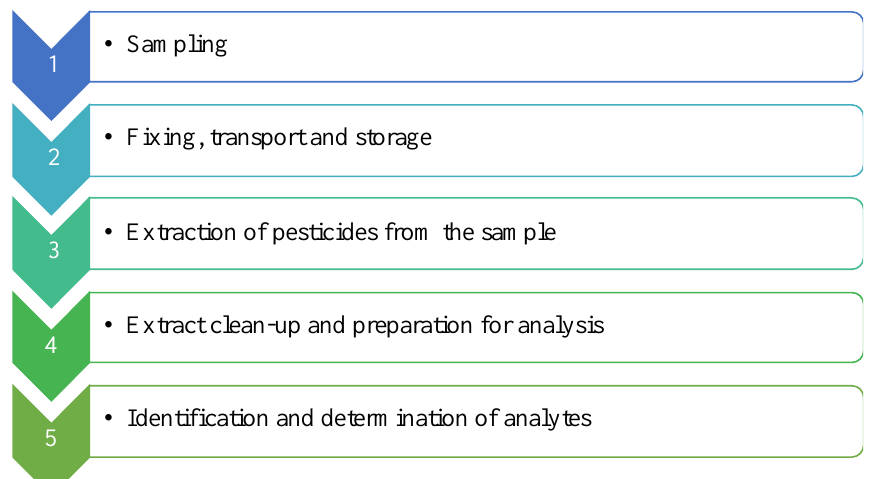
Figure 2. The main stages of analytical procedures for determining pesticides [11].